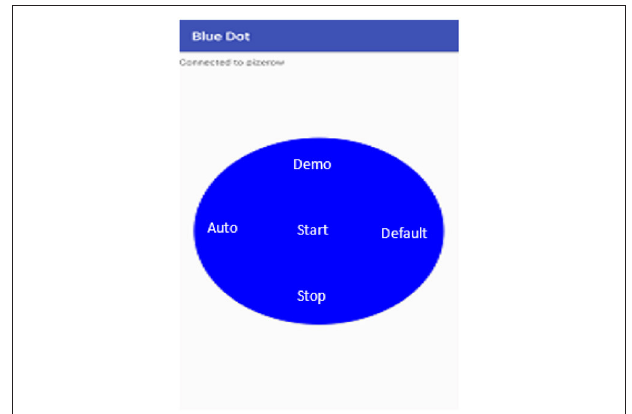
FIGURE 10 | Mobile app main screen with